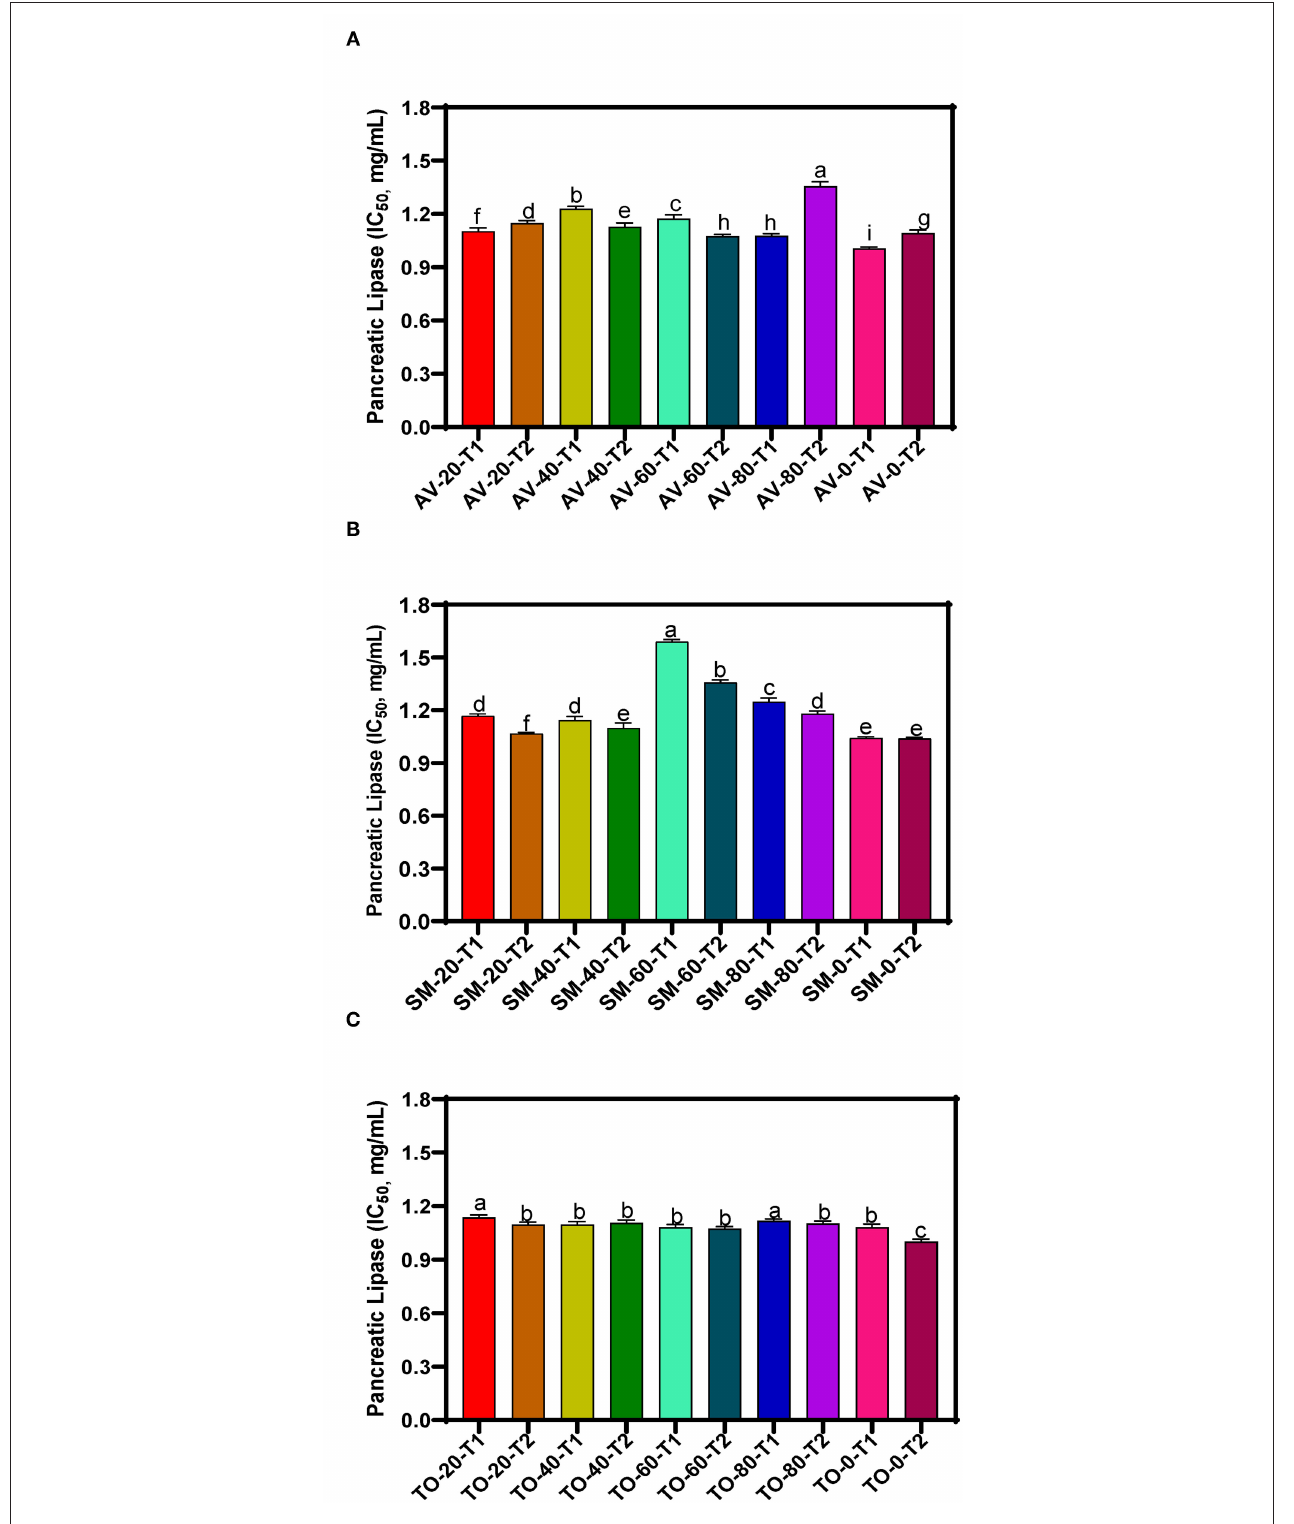
FIGURE 2 | Pancreatic lipase inhibition of aqueous extracts from the dried leaves of (A) Amaranthus viridis leaves (AV), (B) Solanum macrocarpon (SM) and (C) Telfairia occidentalis (TO). Plants were produced with different urea fertilizer doses (0, 20, 40, 60, and 80 kg N/ha), which were applied at (T1) or after (T2) planting. Each bar is the mean of 3 determinations while the error bar represents standard deviation. Bars with different letters (a–g) have mean values that are significantly ( p < 0.05) different.